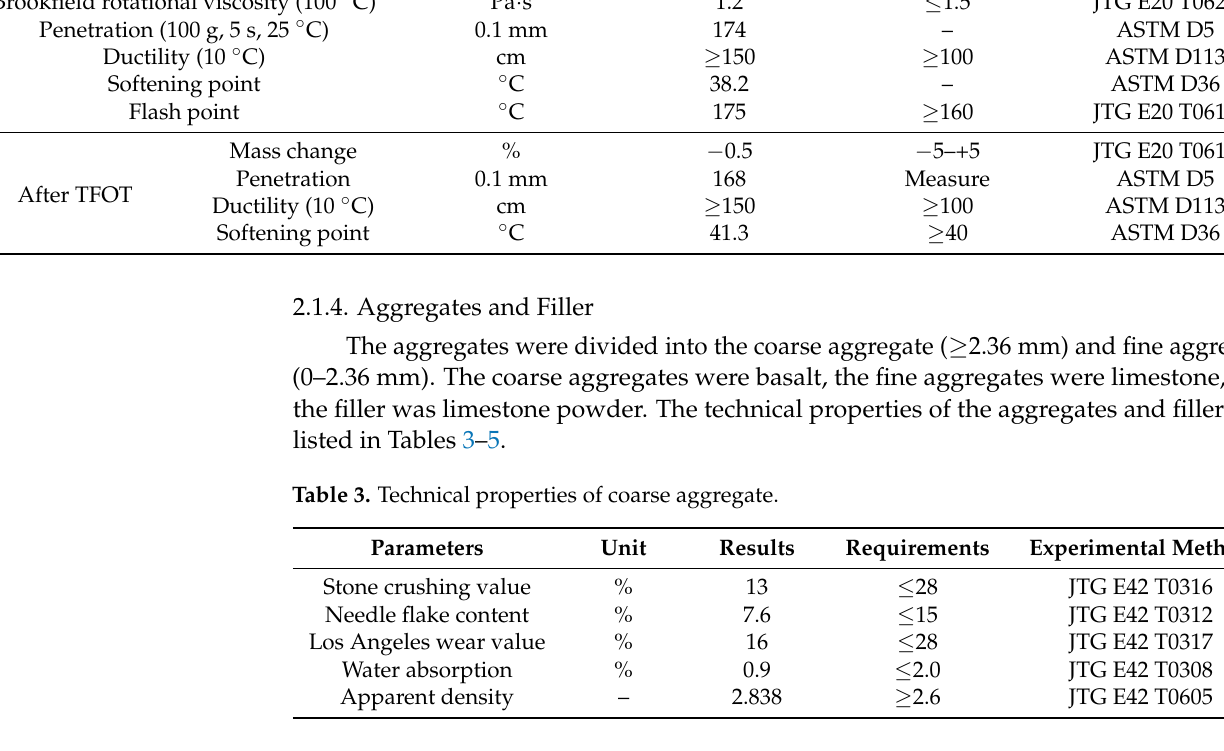
Table 4. Technical properties of fine aggregate.